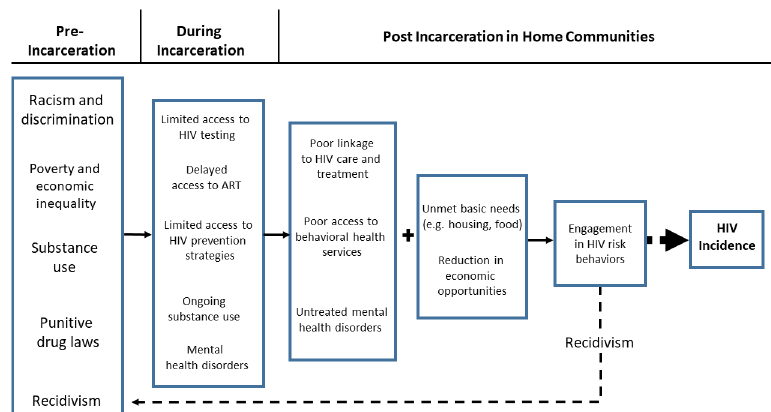
Fig 1. Drivers of onward HIV transmission from pre-incarceration to release in home